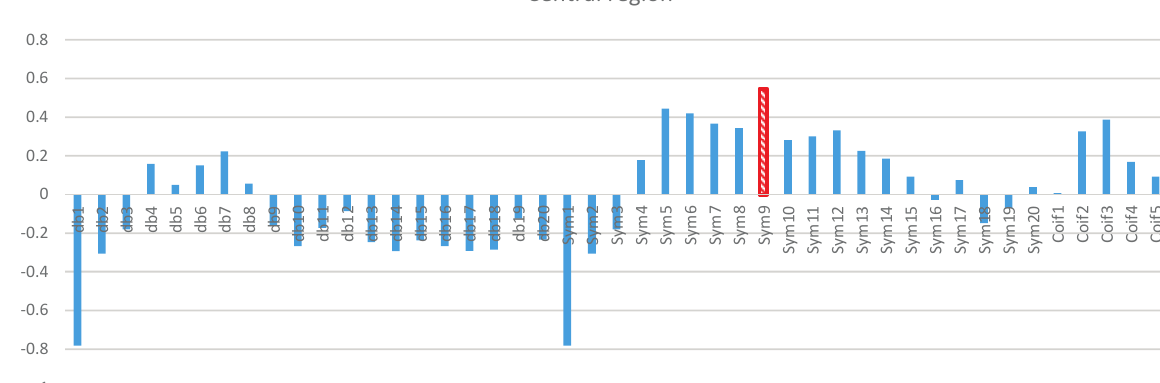
Figure 10. Comparative plot of correlation coefficients with 45 mother wavelet filter for the occipital region of the brain for 10 control subjects.